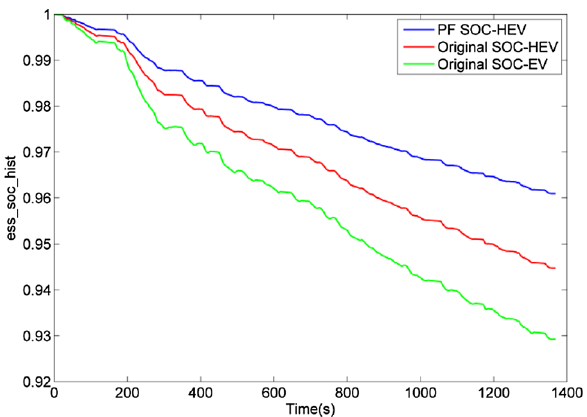
Fig. 12 Current curves of power battery under